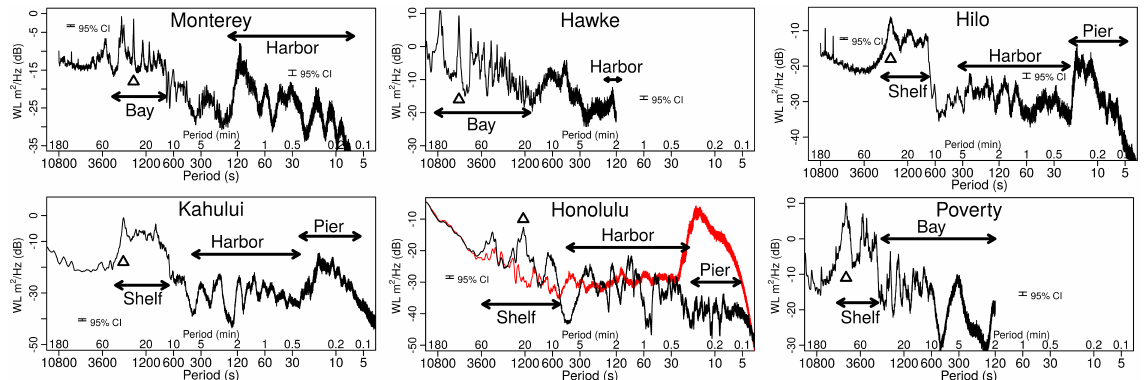
Figure 3. Power spectral density (PSD) estimates of water level (WL) at each tide gauge. Horizontal arrows indicate the frequency span of resonant modes associated with spatial scales. Triangles mark the tidally forced shelf resonance. The red curve at Honolulu plots data from outside the